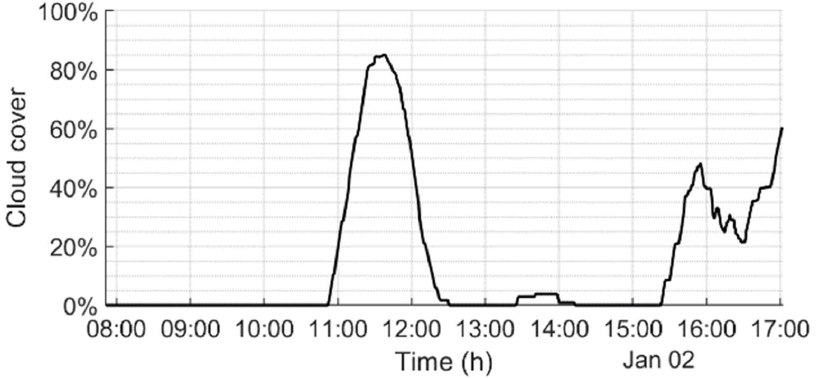
Figure 6. Cloud cover percentage on 2nd January.